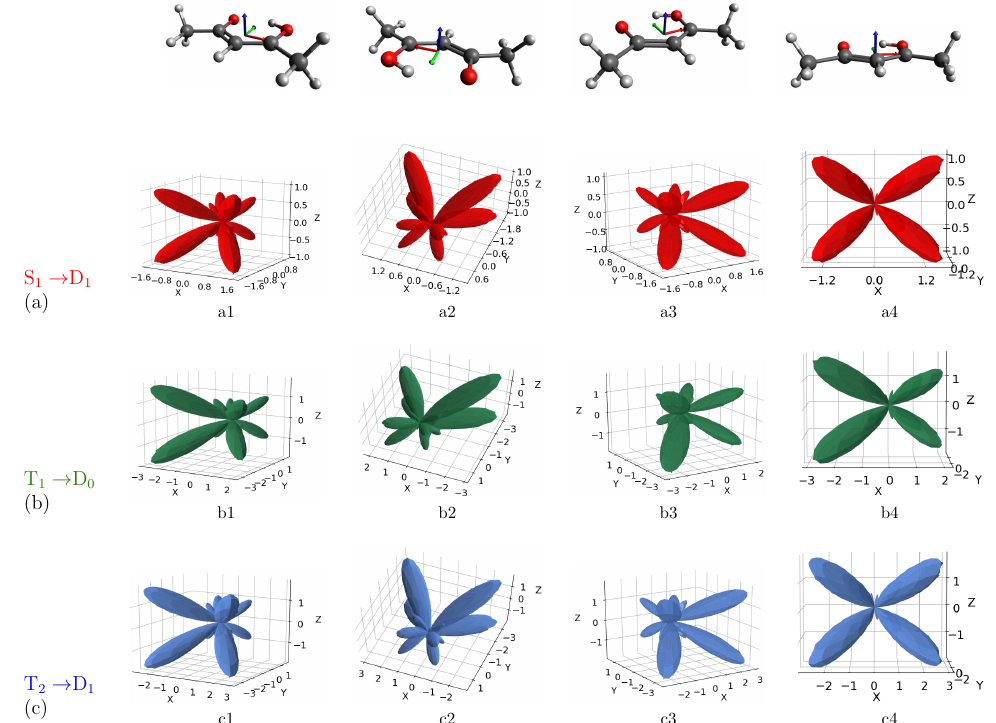
Figure 4. Computed MFPADs for the photoionization from the S 1 ( a ), T 1 ( b ), and T 2 ( c ) excited states of acetylacetone to the corresponding first ionic state, at the selected kinetic energy of 6.04 eV. The electric field is oriented along the y-axis. Orientation of the molecule is also shown on top of figure (x, y, z axes are, respectively, identified by red, green and blue